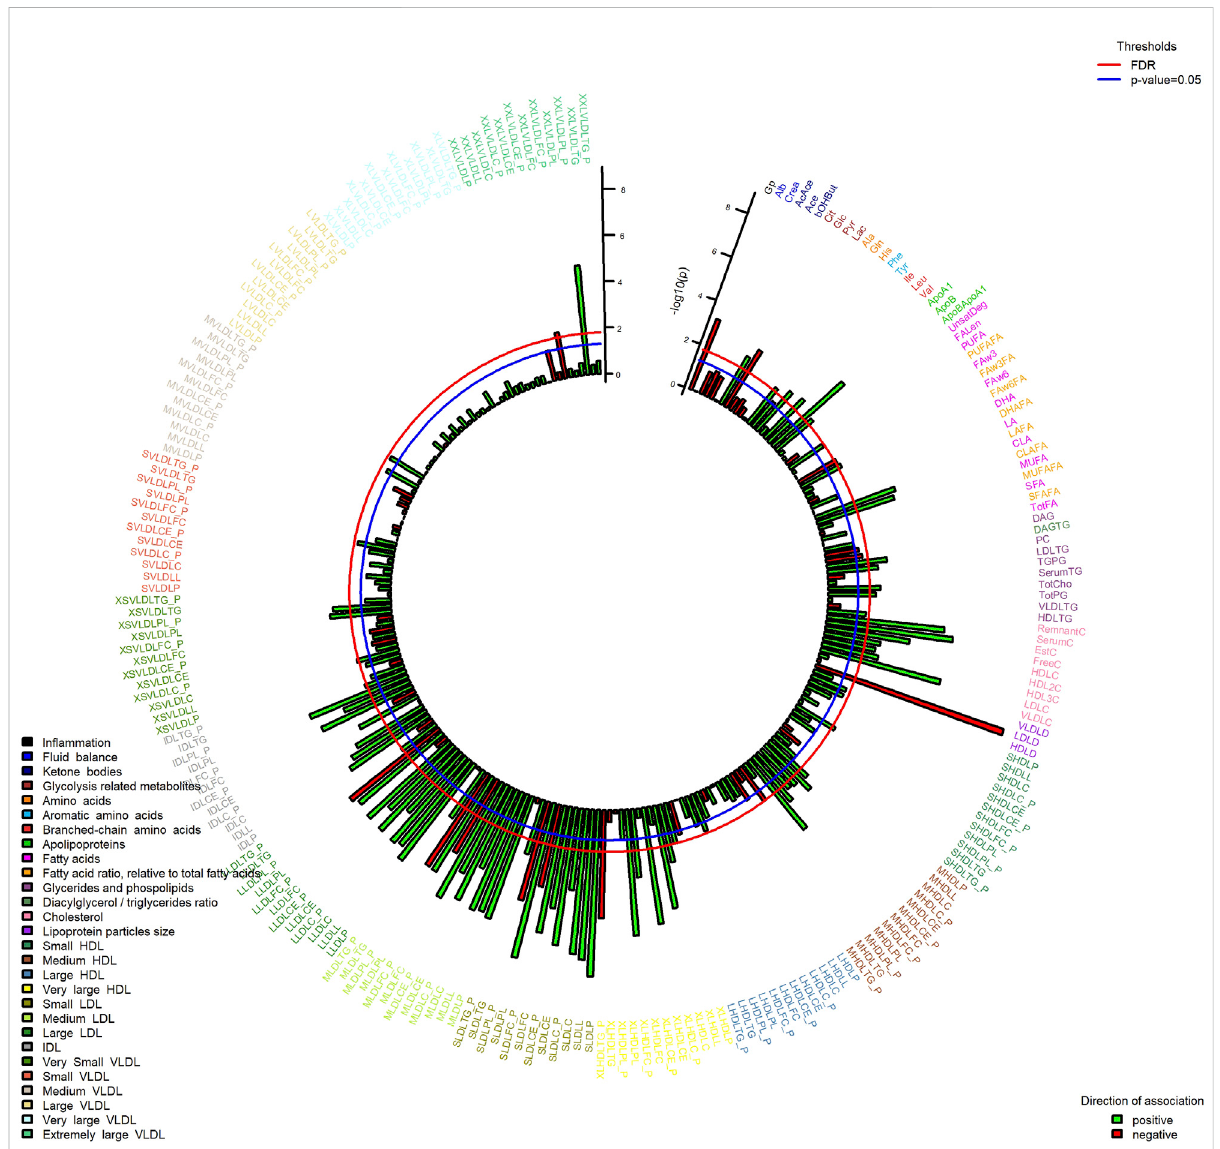
FIGURE 3 Associationsofmetabolicmeasuresat7 yearsSMFQscoreat11 years(outcome).Barsshowstrengthofassociation(-log10 p -value),coloredby direction of effect. Model is adjusted for sex and age of child, physical activity at age 5, mother ’ s age at birth, birthweight, mother ’ s pre-pregnancy BMI, average weekly family income at 7, mother ’ s highest education quali fi cation. FDR at 5%. The abbreviation of the metabolites is available in the Codebook (Supporting Information